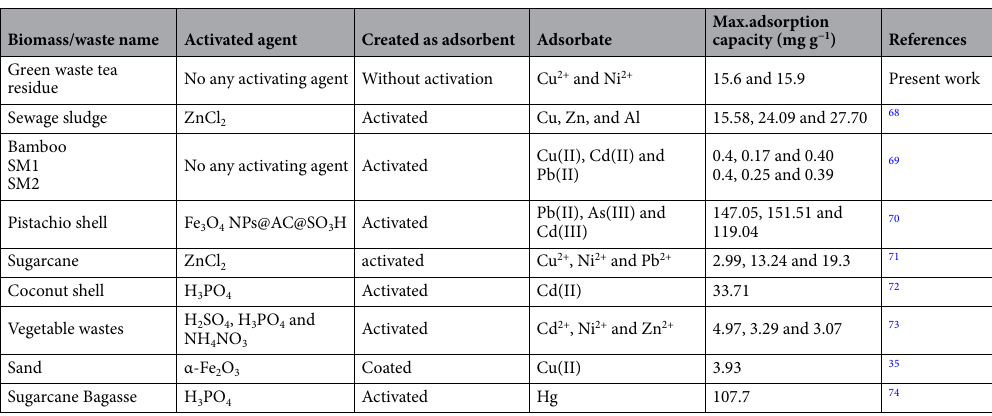
Table 2. Comparison of maximum adsorption capacities for heavy metals on some adsorbents